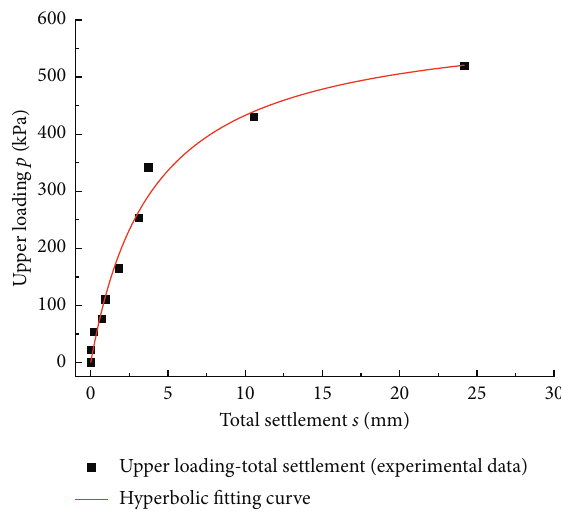
Figure 11: Fitted p − s hyperbolic curve of the single pile com- posite